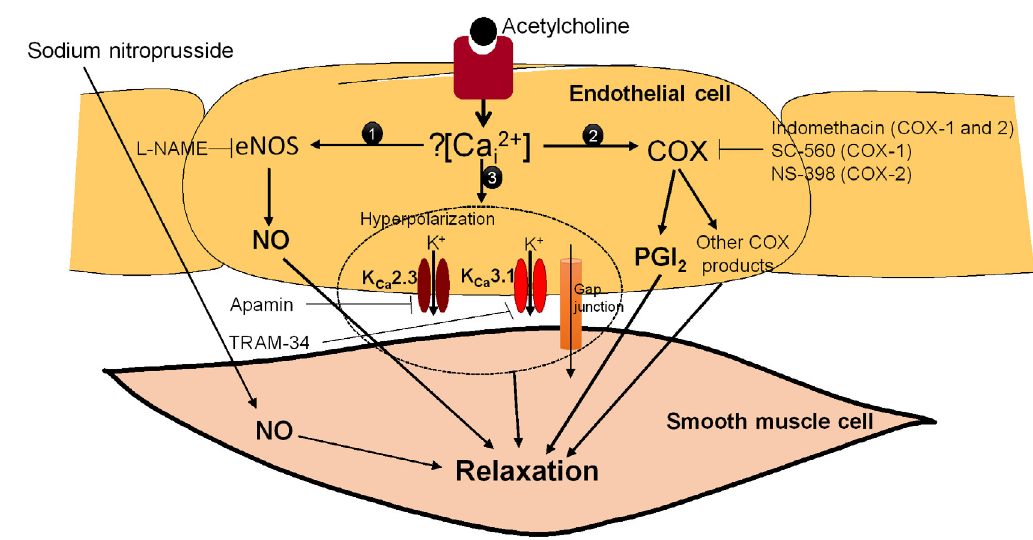
Figure 1- Endothelium-dependent vasodilation. Acetylcholine induces an increase in intracellular calcium concentration and leads to ), in addition to the opening of potassium channels, which in turn the production and release of nitric oxide (NO) and prostacyclin (PGI 2 induces vascular smooth muscle cell relaxation. NO diffuses to the underlying smooth muscle cell and induces relaxation by increasing the production of cGMP. Prostacyclin is the main prostanoid synthesized by vascular endothelium, and acts via the prostacyclin receptor (IP). The opening of intermediate conductance calcium-activated potassium channels (Kca3.1) and small conductance calcium-activated potassium channels (Kca2.3) in the endothelial cell induces vascular smooth muscle cell hyperpolarization, which is evoked by